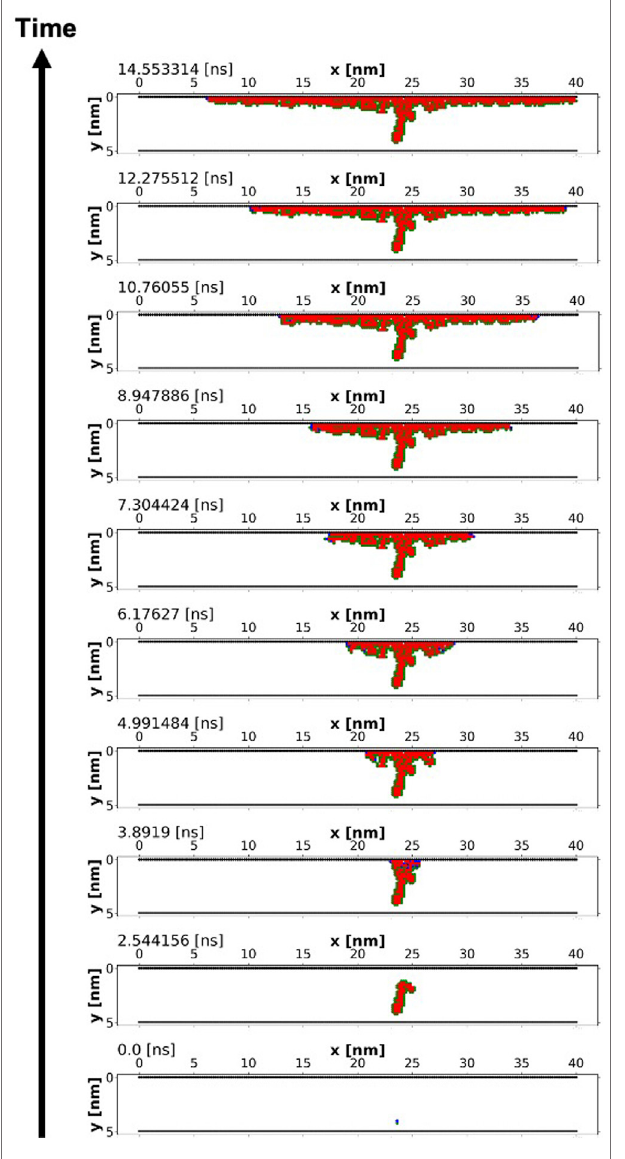
FIGURE 5 | An example of fi lament formation dynamics with the top electrode at 3 V and the bottom electrode at 0 V. The red squares are the fi lament,thegreencirclesareoxygenionsandthebluecirclesareunoccupied oxygen vacancies.